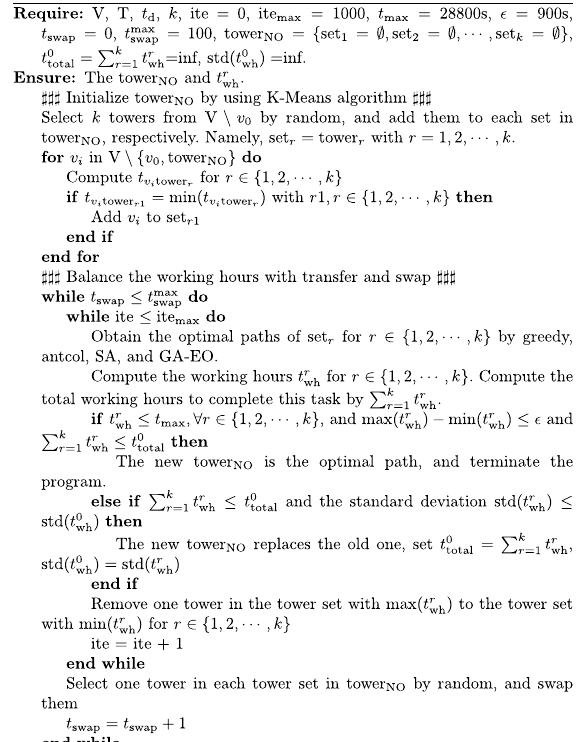
Frontiers in Physics |